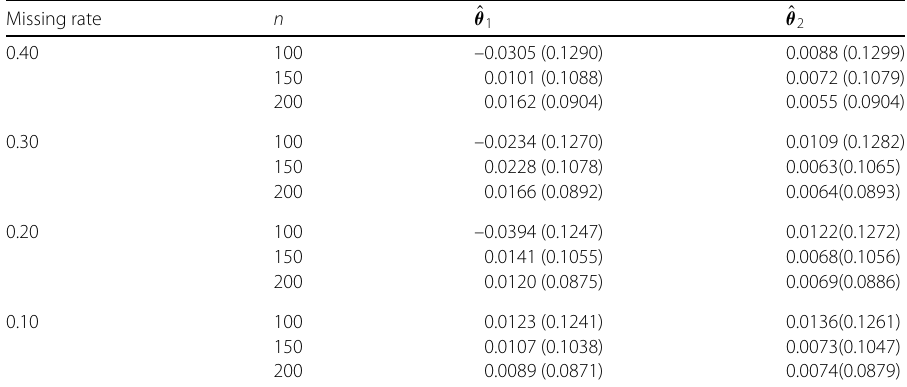
Table 1 Biases and SE of ˆ θ 1 , ˆ θ 2 under different missing functions and different sample sizes Missing